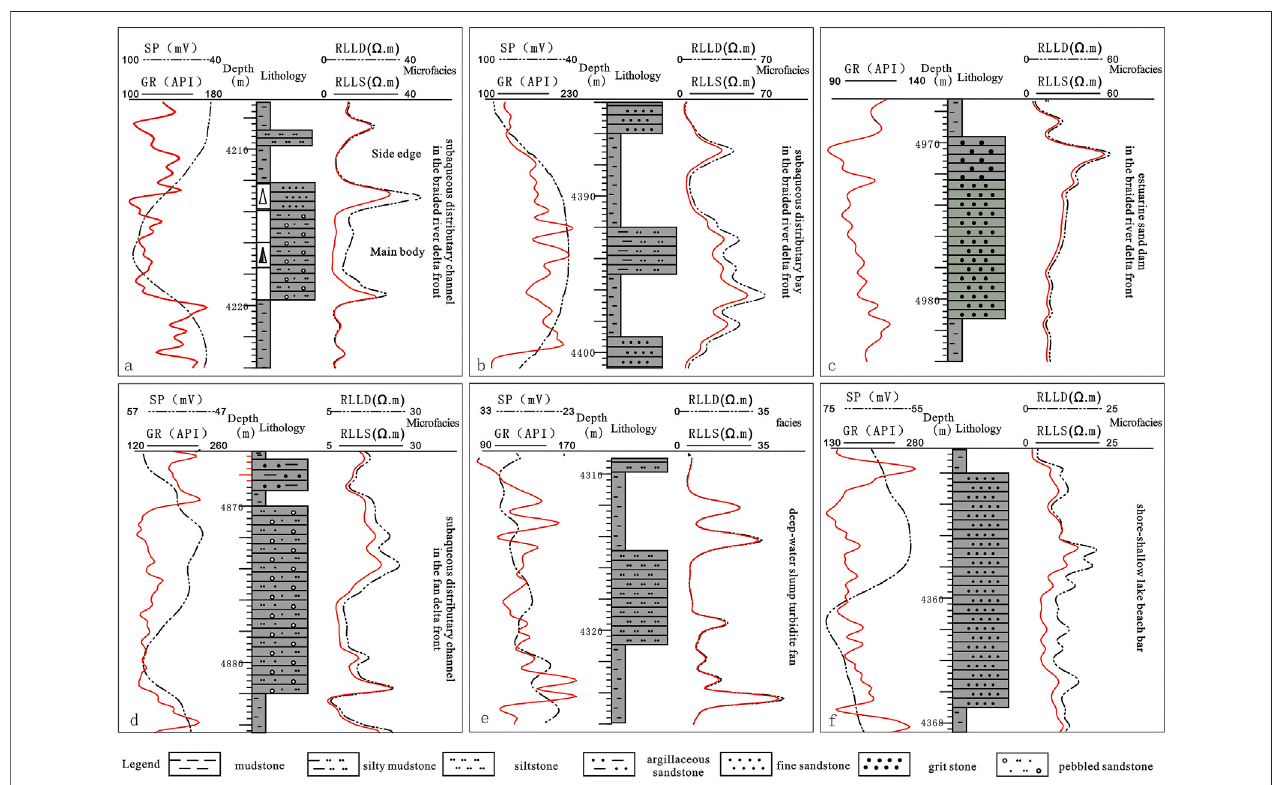
FIGURE 5 | Lithologic assemblage and logging response characteristics of the different sedimentary facies in the middle and deep layers of the Nanpu No. 3 structural area. (A) NP3-26, SQ4; (B) PG2, SQ4; (C) NP306 × 3, SQ4; (D) NP3-82, SQ2; (E) NP3-27, SQ5; (F) NP3-82, SQ4.